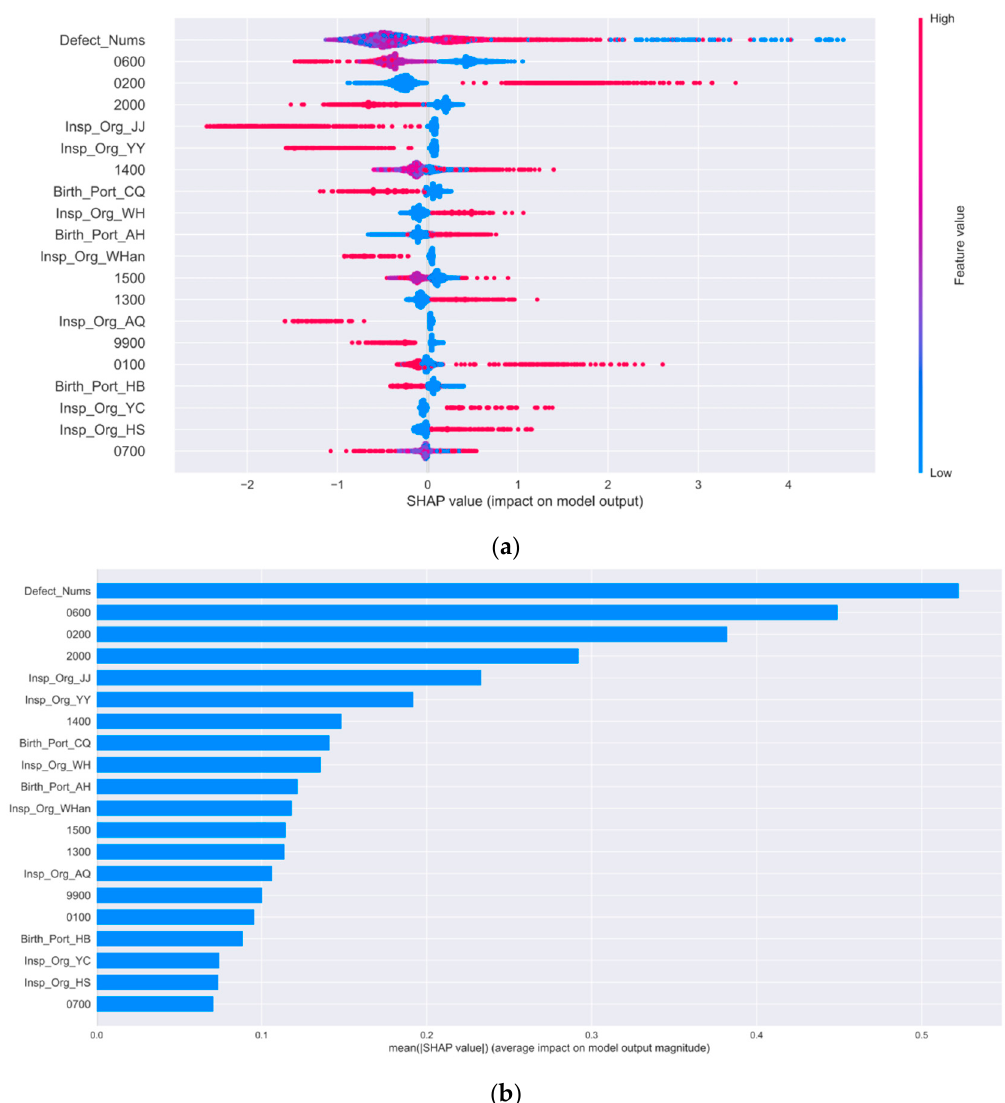
Figure 10. Top 20 features sorted by the Shapley additive explanations (SHAP) method. ( a ) Summary plot, SHAP values of each feature of each sample; ( b ) feature rankings based on SHAP values.